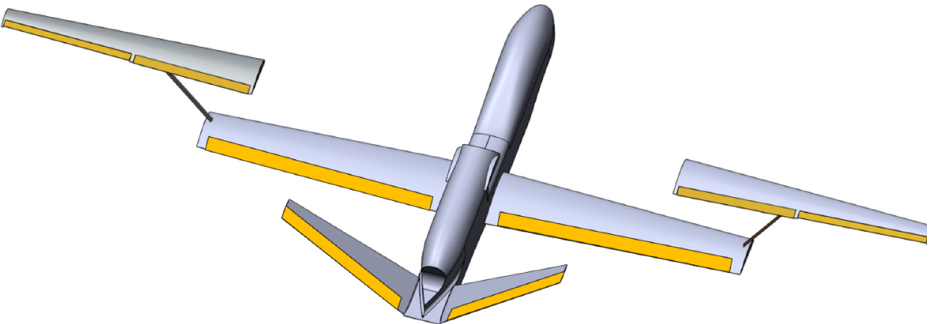
Figure 15. Rudder layout of the mono-biplane aerodynamics-driven morphing UAV. Table 3. Wing and rudder parameters of the mono-biplane aerodynamics-driven morphing UAV.